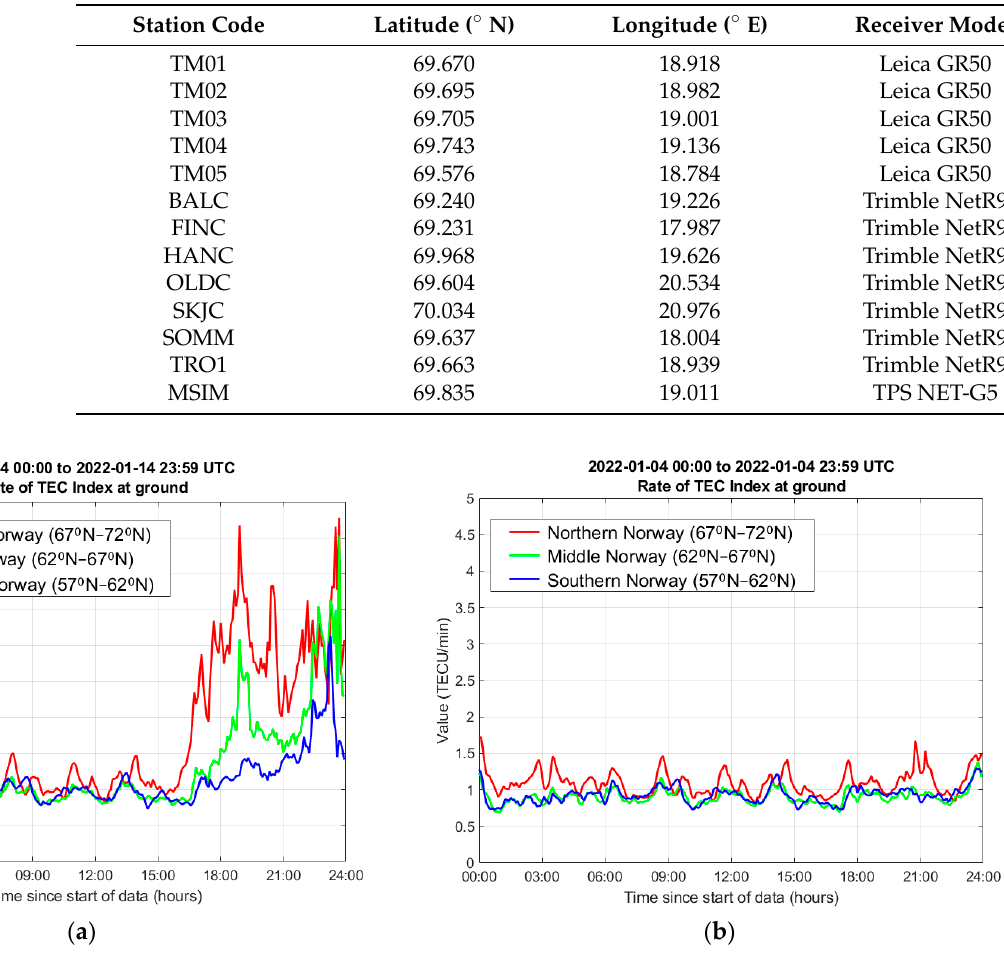
Figure 2. Rate of TEC Index at ground measured based on the observations from the NMA operated SATREF network. ( a ) A day with moderate-high ionospheric activity, 14 January 2022; ( b ) a day with low ionospheric activity, 4 January 2022.